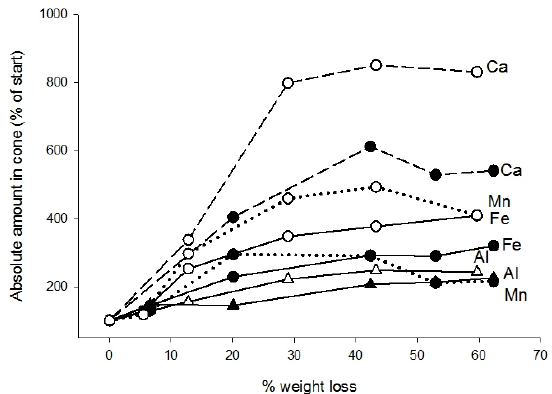
Figure 3. Changes in the absolute amount of iron (solid lines and round symbols), aluminium (solid lines and triangles), calcium (stippled lines) and manganese (dotted lines) during decomposition of cones. Filled symbols: moss habitat. Open symbols: needle mat habitat. All lines start at 100% for newly shed cones. From [16].